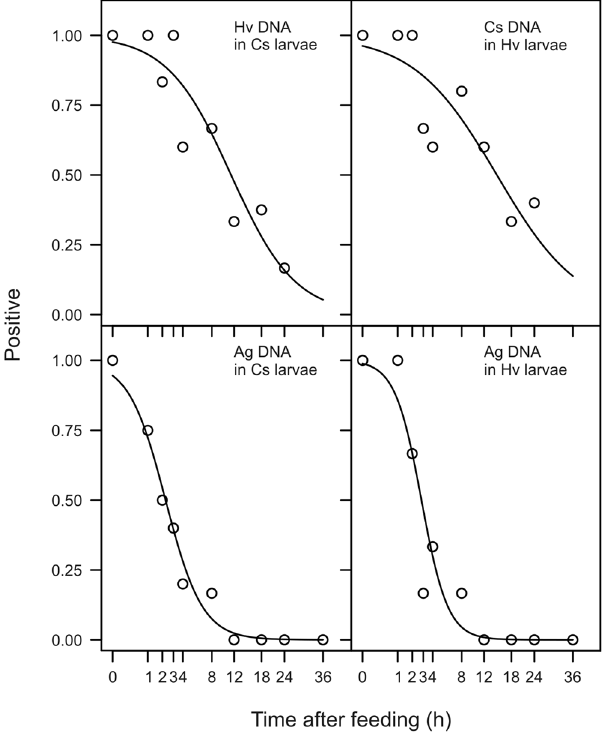
Figure 1. Positive detection of prey DNA following consumption by predatory 4 th instars. Hv = H . variegata ; Cs = C . septempunctata ; Ag = Aphis gossypii . Symbols represent observed proportions of positive amplifications. Lines represent fitted binomial